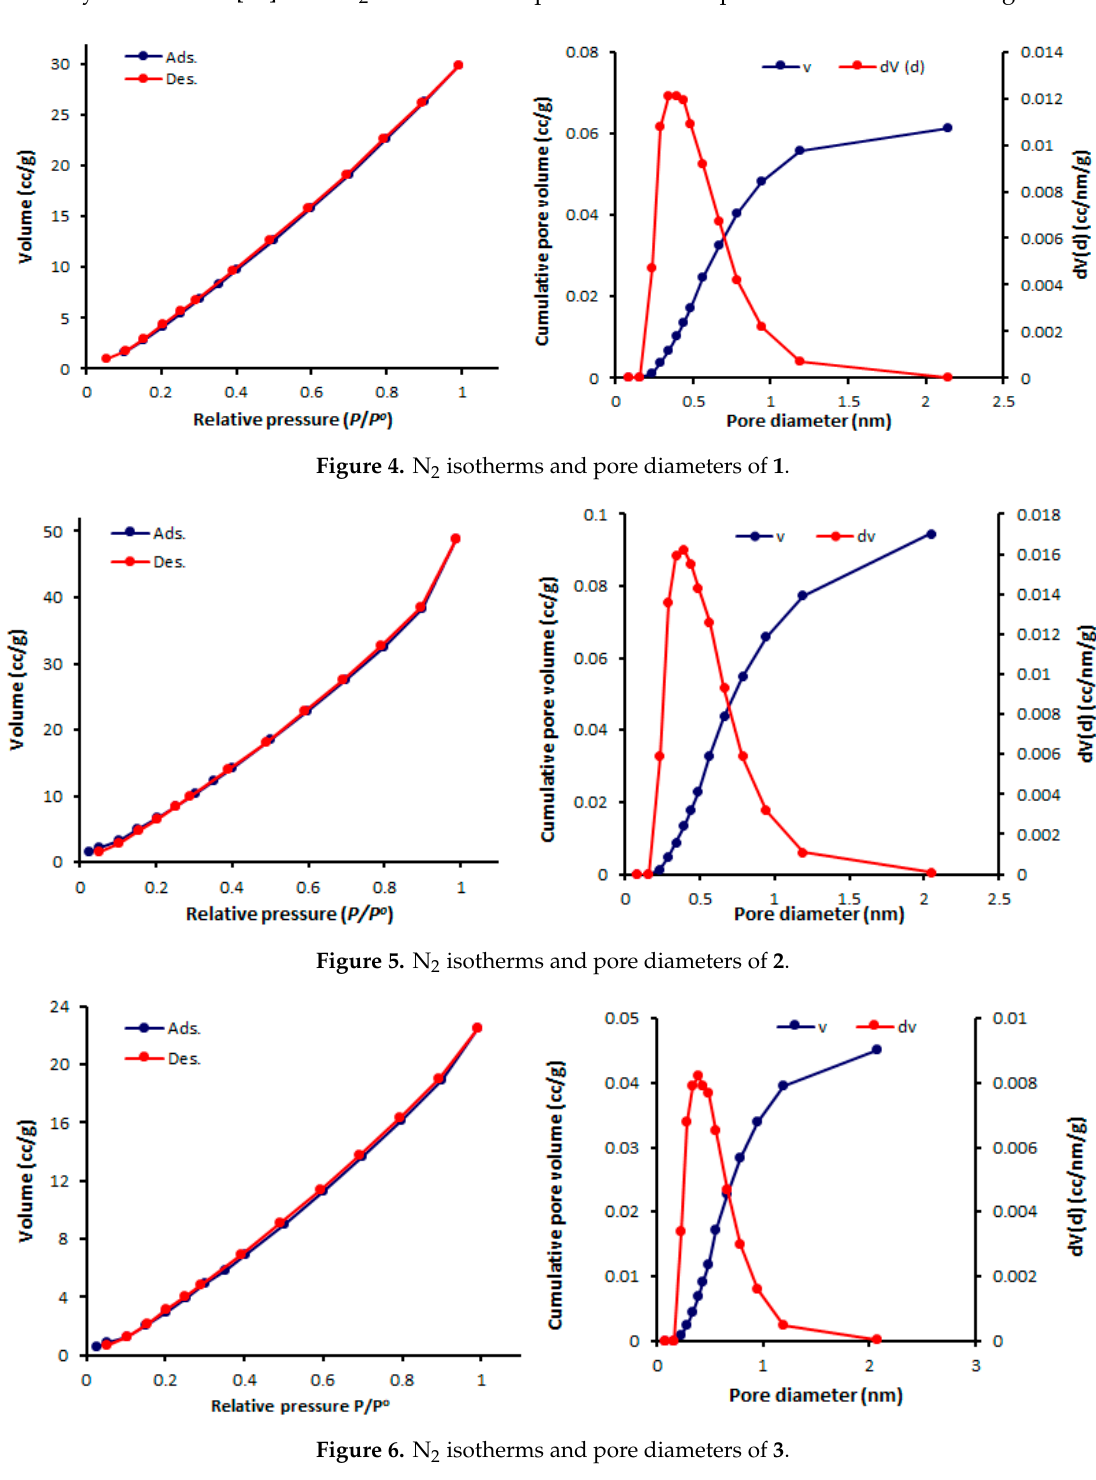
Figure 6. N 2 isotherms and pore diameters of 3 .